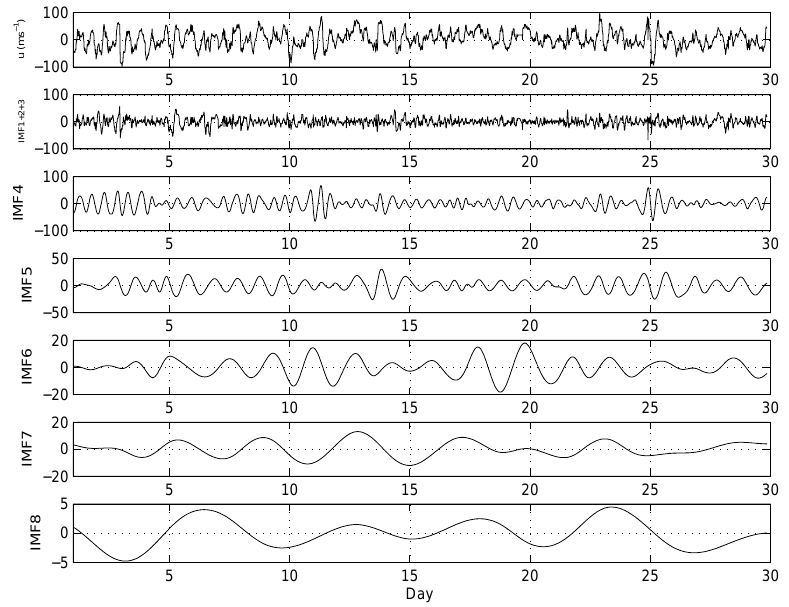
Fig. 2. The results of application of the EMD technique to the zonal wind time series observed by the Scott Base radar at 90km in January 2006 are displayed. The upper panel in this figure displays the original time series. The second panel contains the summation of the first to third IMFs, the third panel contains the fourth IMF, the fourth panel the fifth IMF etc.